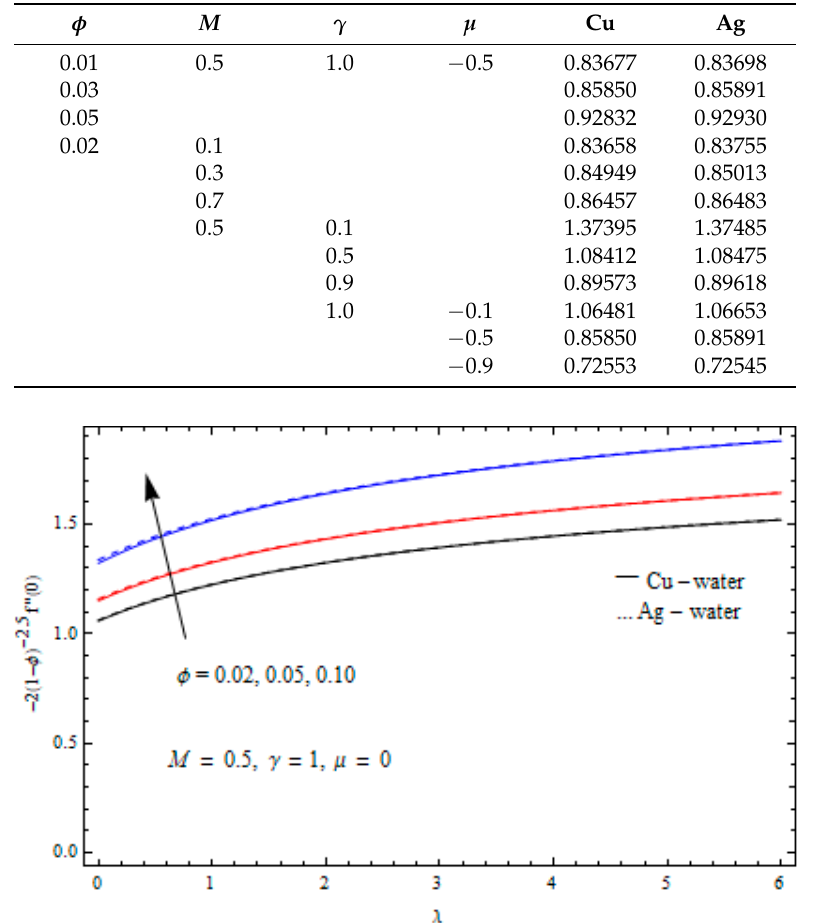
Table 3. Values of skin friction coefficient for copper and silver at various values of φ , M , γ and µ at λ = 0.4.